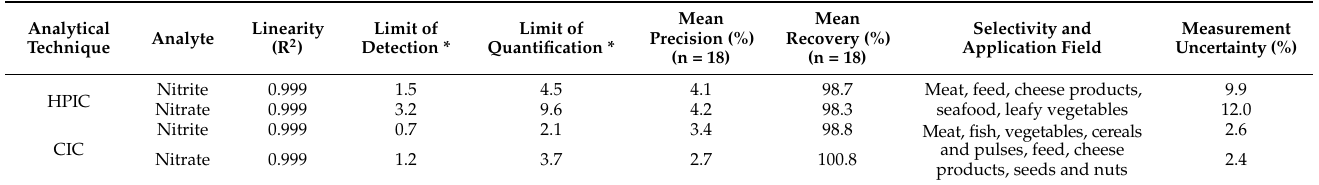
Table 1. Main validation parameters of high-pressure ion chromatography (HPIC) and capillary ion chromatography